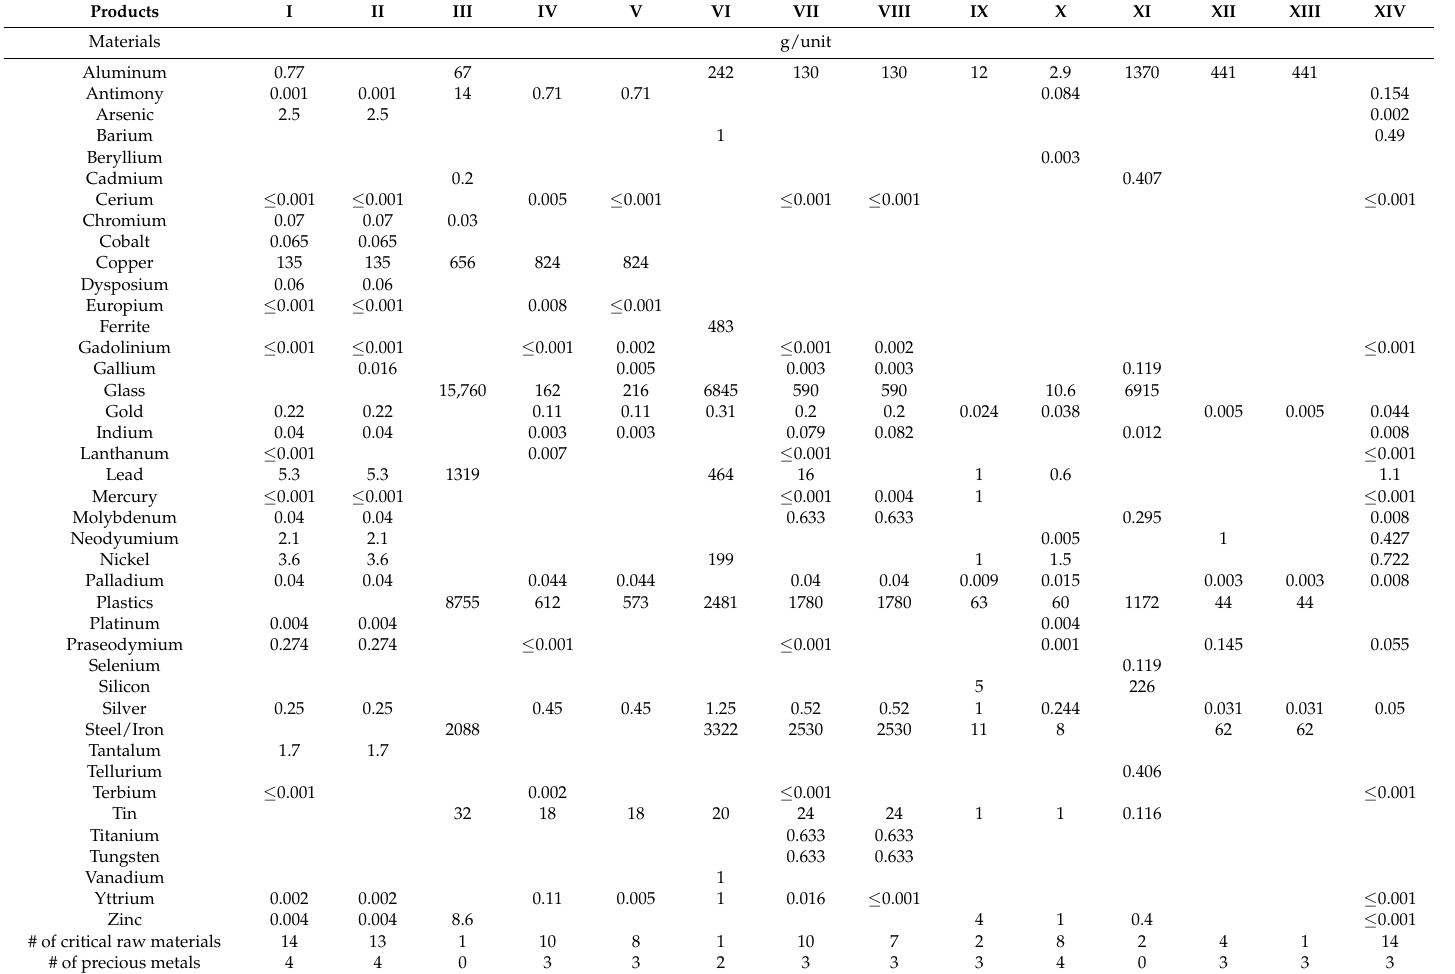
Table 11. Material Composition of electronic equipment. Adapted from [93], with permission from © 2015